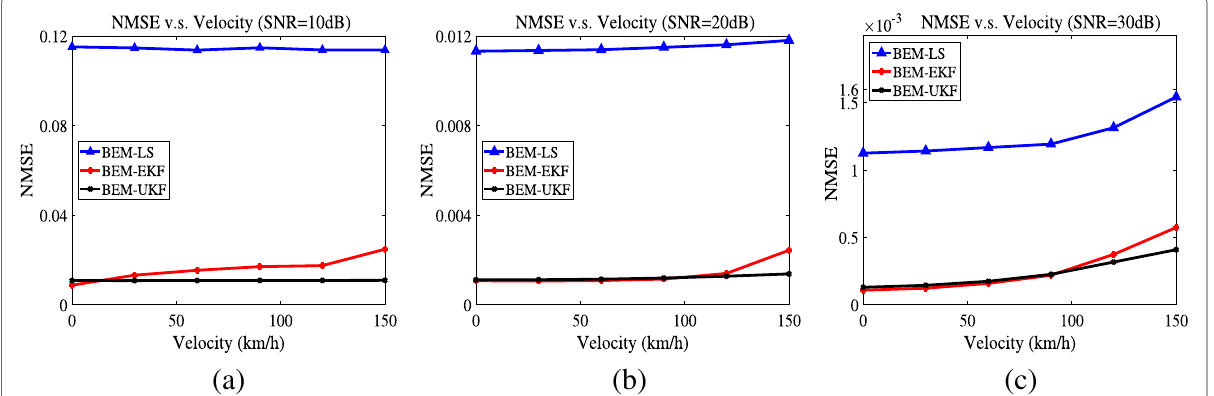
Fig. 5 NMSE for channel estimation methods in V2V environments with different velocities. NMSE of BEM-EKF and BEM-UKF are nearly one tenth of BEM-LS, because the EKF and UKF could track the change of channel in high velocity